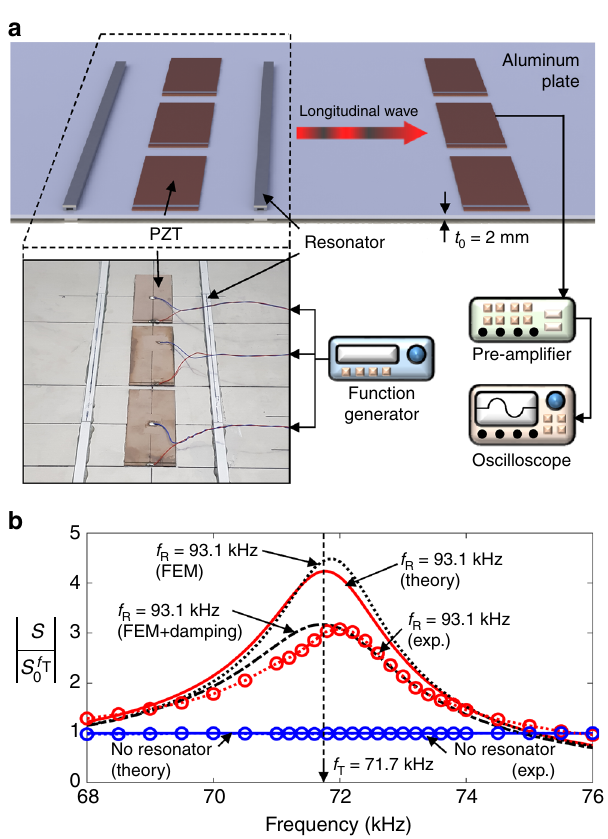
Fig. 4 Experimental demonstration in thin plate. a Set-up for longitudinal wave experiments in thin plate. Three PZT patches were used to ensure the generation of a plane longitudinal wave mode in the plate. b A comparison of the experimental and theoretical/numerical results for the radiated strain fi eld | S |